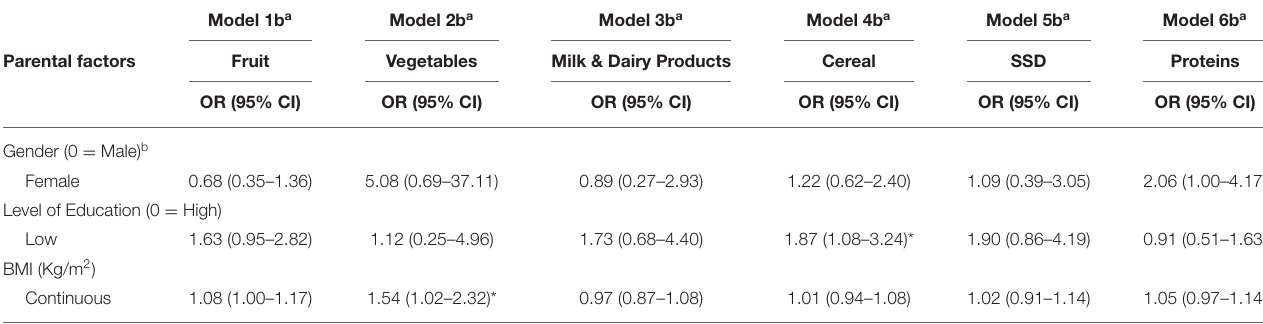
TABLE 2B | Logistic regression analyses of the associations between parent-related factors and adherence of the children to the guidelines of the Swiss Society of Nutrition ( n = 287), Switzerland